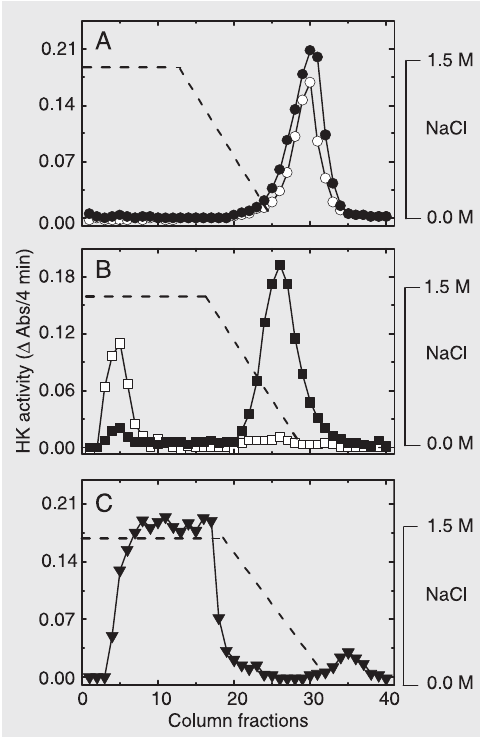
Figure 3. Effect of limited chy- motrypsin hydrolysis on hy- drophobic interaction chroma- tographic behavior of maize, rat and yeast hexokinases. A , NC-HK 1 eluted from the DEAE column (Figure 2A) with (open circles) and with-